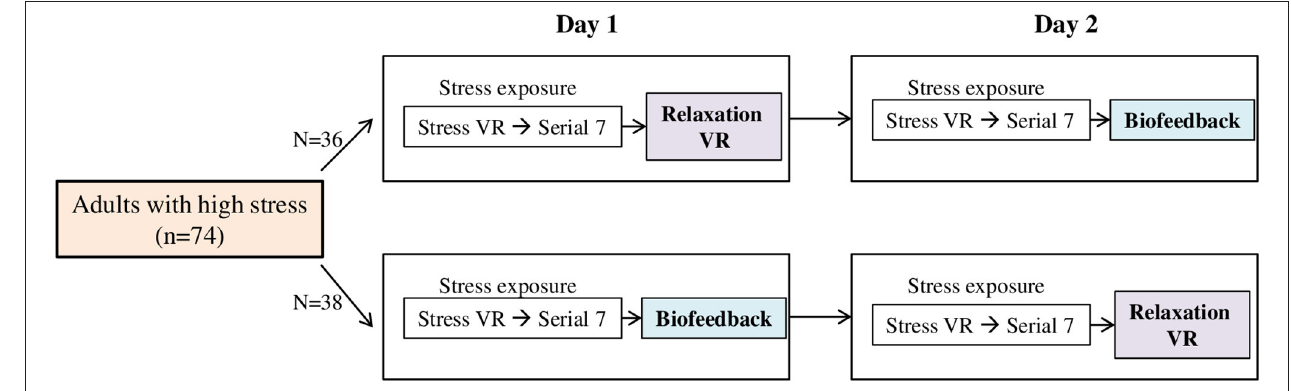
FIGURE 1 | Study design. VR, virtual reality.